Question: Author a descriptive caption for the visualization shown.
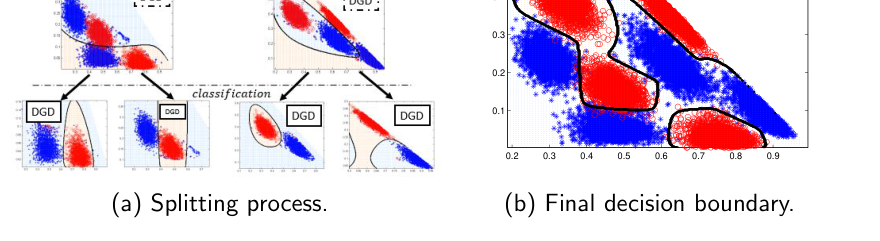
Answer: Illustration of the HMGD splitting process and the final decision boundary. The solid curve is the regions (resp. sub-regions or classes) boundary. In ”a)” each split is performed by a DGD model.